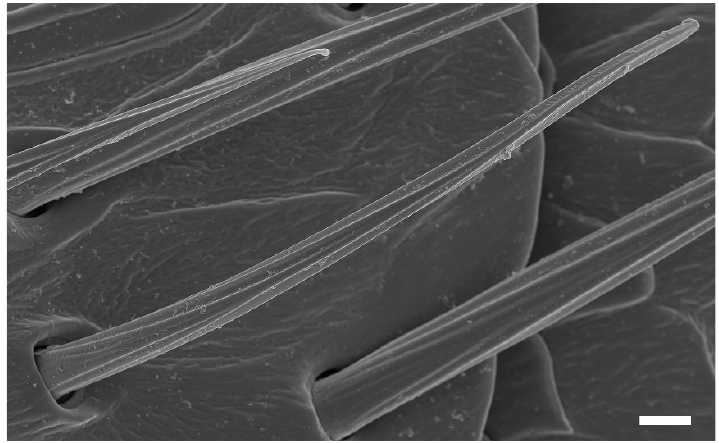
Figure 5. Characteristic ribbed hairs of sensilla trichodea emerging from flexible cuticular sockets. Scale bar = 2 μ m.